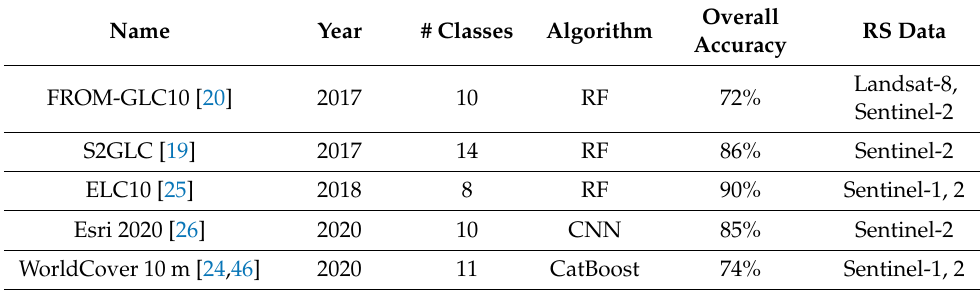
Table 1. Available 10 m LULC maps, covering the entire continent of